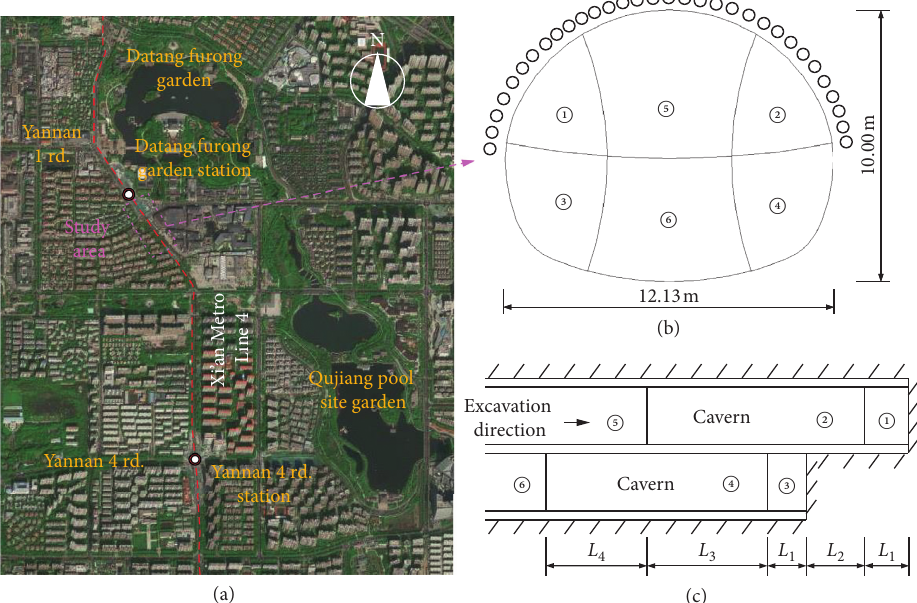
(c)(b)Yannan Figure 1: Xi’an Metro Line 4 and double-sides heading method. (a) Direction of Xi’an Metro Line 4. (b) Subsection construction process of double-sides heading method. (c) Construction sequence of the longitudinal section of tunnel